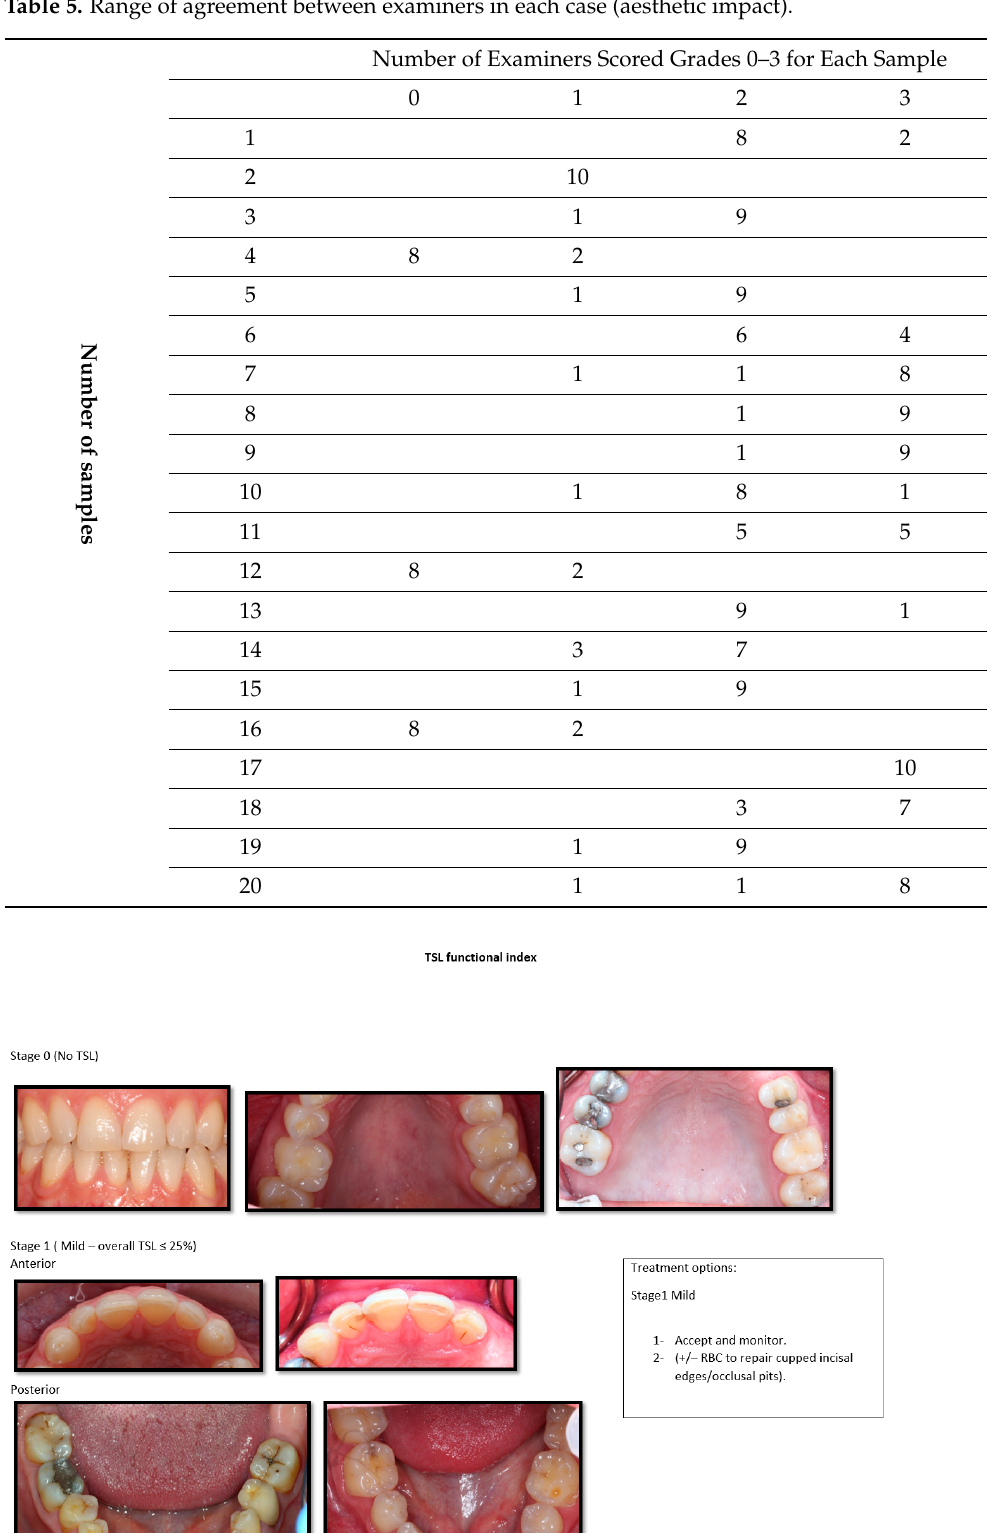
Table 5. Range of agreement between examiners in each case (aesthetic impact).